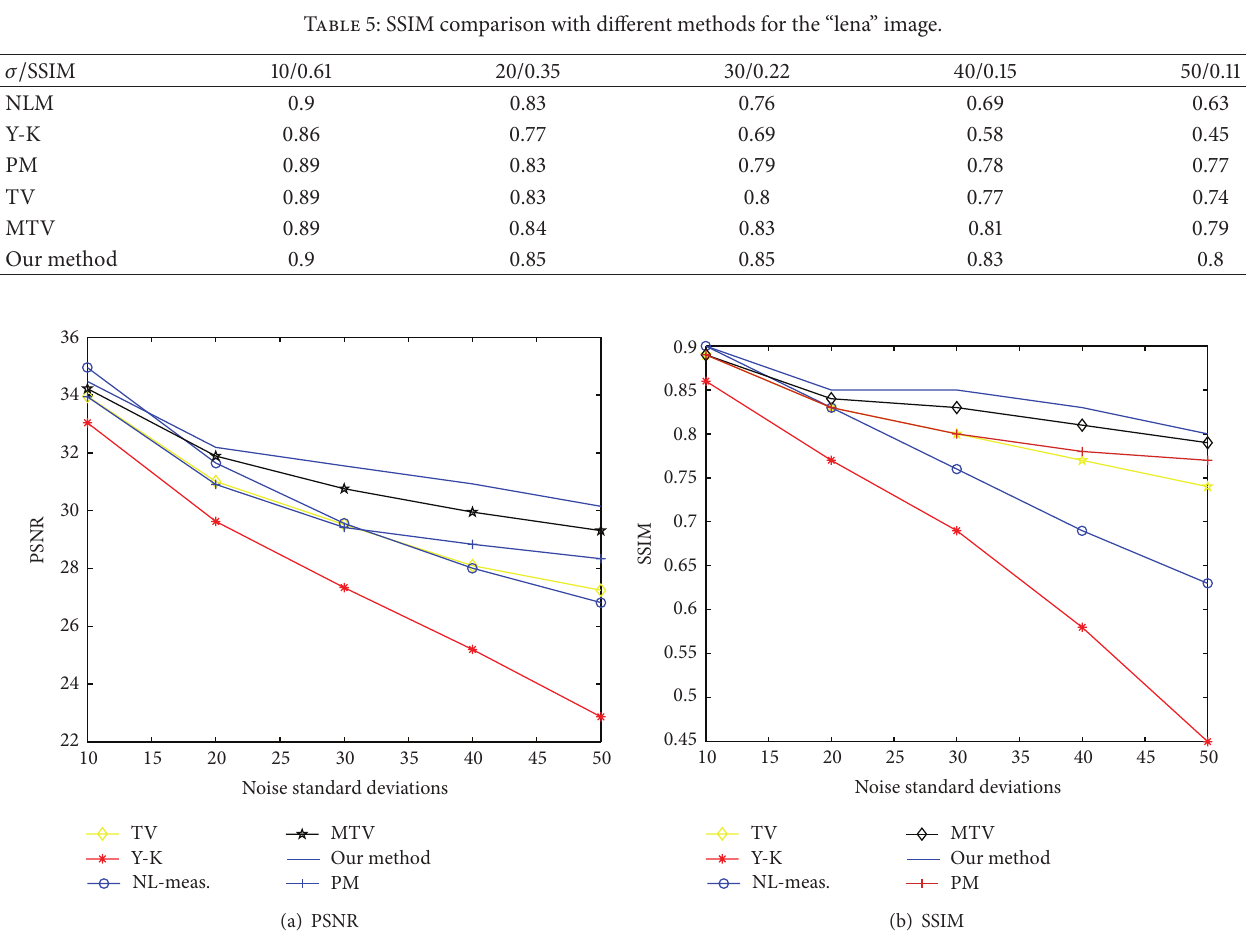
Figure 7: PSNR and SSIM values of six models for denoising lena